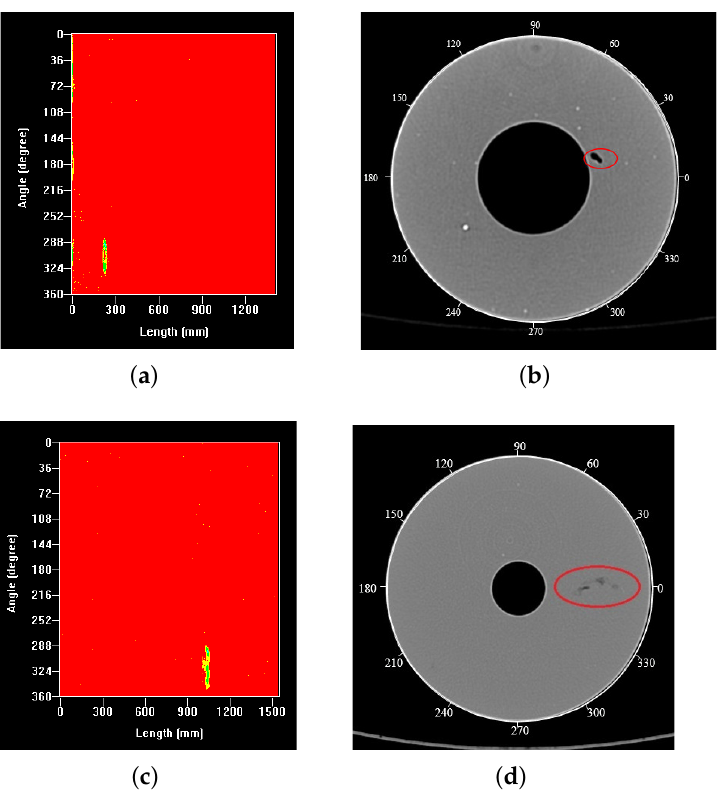
Figure 13. Natural defects (( a ) natural defect I(UT), ( b ) natural defect I(CT), ( c ) natural defect II(UT), and ( d ) natural defect